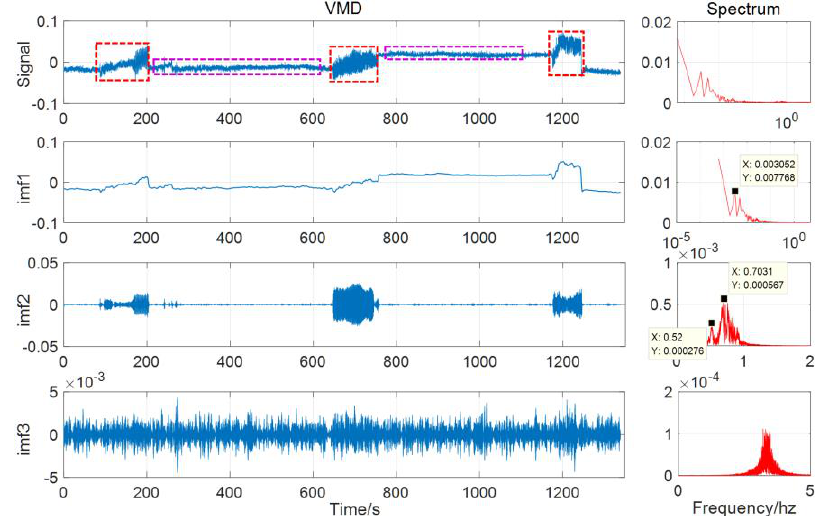
Figure 11. The VMD result of GNSS (Global Navigation Satellite System) (the vertical axis represents the displacement/m).